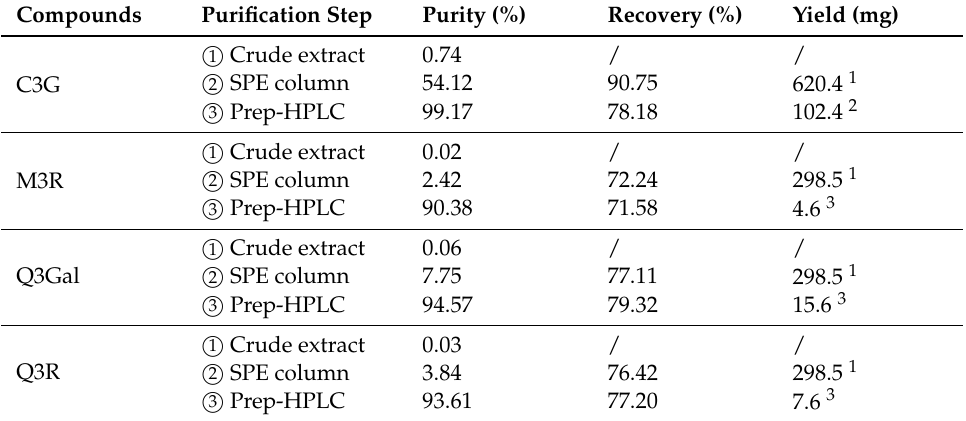
Table 1. Purities and recoveries of four flavonoid glycosides in the two-step purification